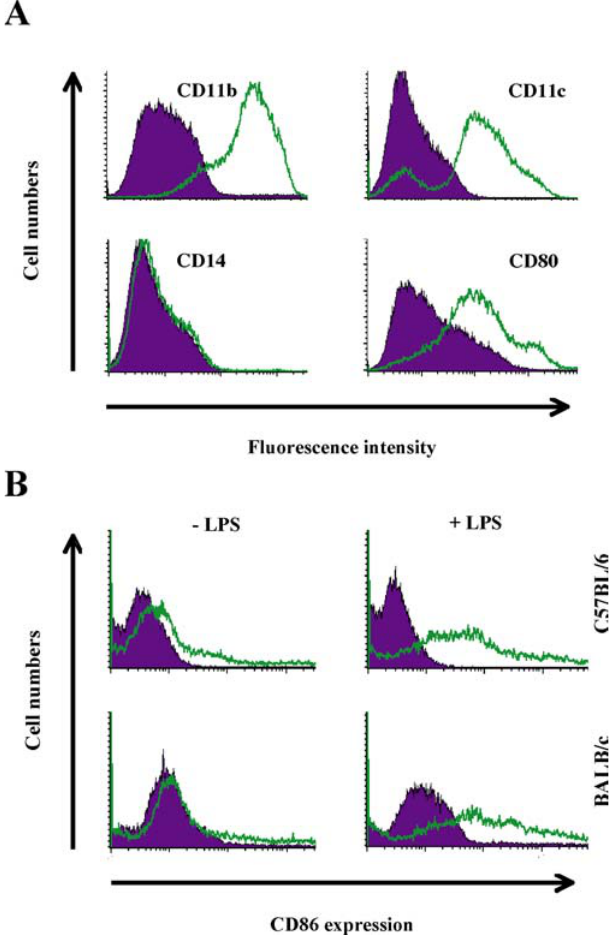
Figure 3. FACS Profile of BMDCs (A) BMDCs were derived from a BALB/c mouse and analyzed on day 10. Expression of CD11b, CD11c, CD14, and CD80 was assessed by flow cytometry. The data are representative of four similar experiments in BALB/c and C57BL/6 mice. (B) BALB/c and C57BL/6-derived BMDCs were stimulated by LPS for 18 h, and CD86 expression was measured by flow cytometry. Filled histograms represent isotype-matched controls. DOI: 10.1371/journal.ppat.0010019.g003